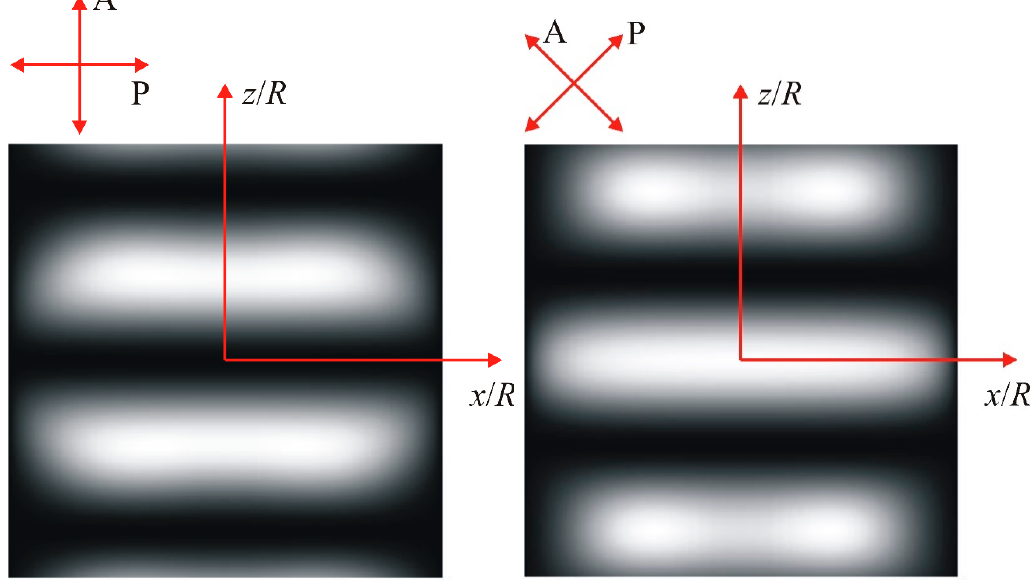
Figure 7. Calculated optical patterns for the RZT structure with Q 1 = Q 2 = 1. The transmitted polarisation of the polariser is in the x direction (left figure) and at an angle of 45 ° with respect to the x direction (right figure). Optical data: R = 1 μ m, laser light wavelength λ = 445 nm, refraction indices: n o = 1.544, n e = 1.821, corresponding to nematic liquid crystal (NLC)